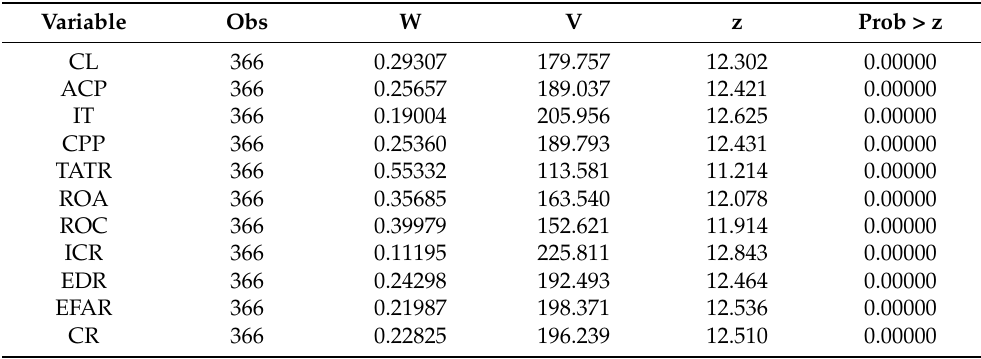
Table A2. Results of Shapiro–Wilk test—prosperous businesses.